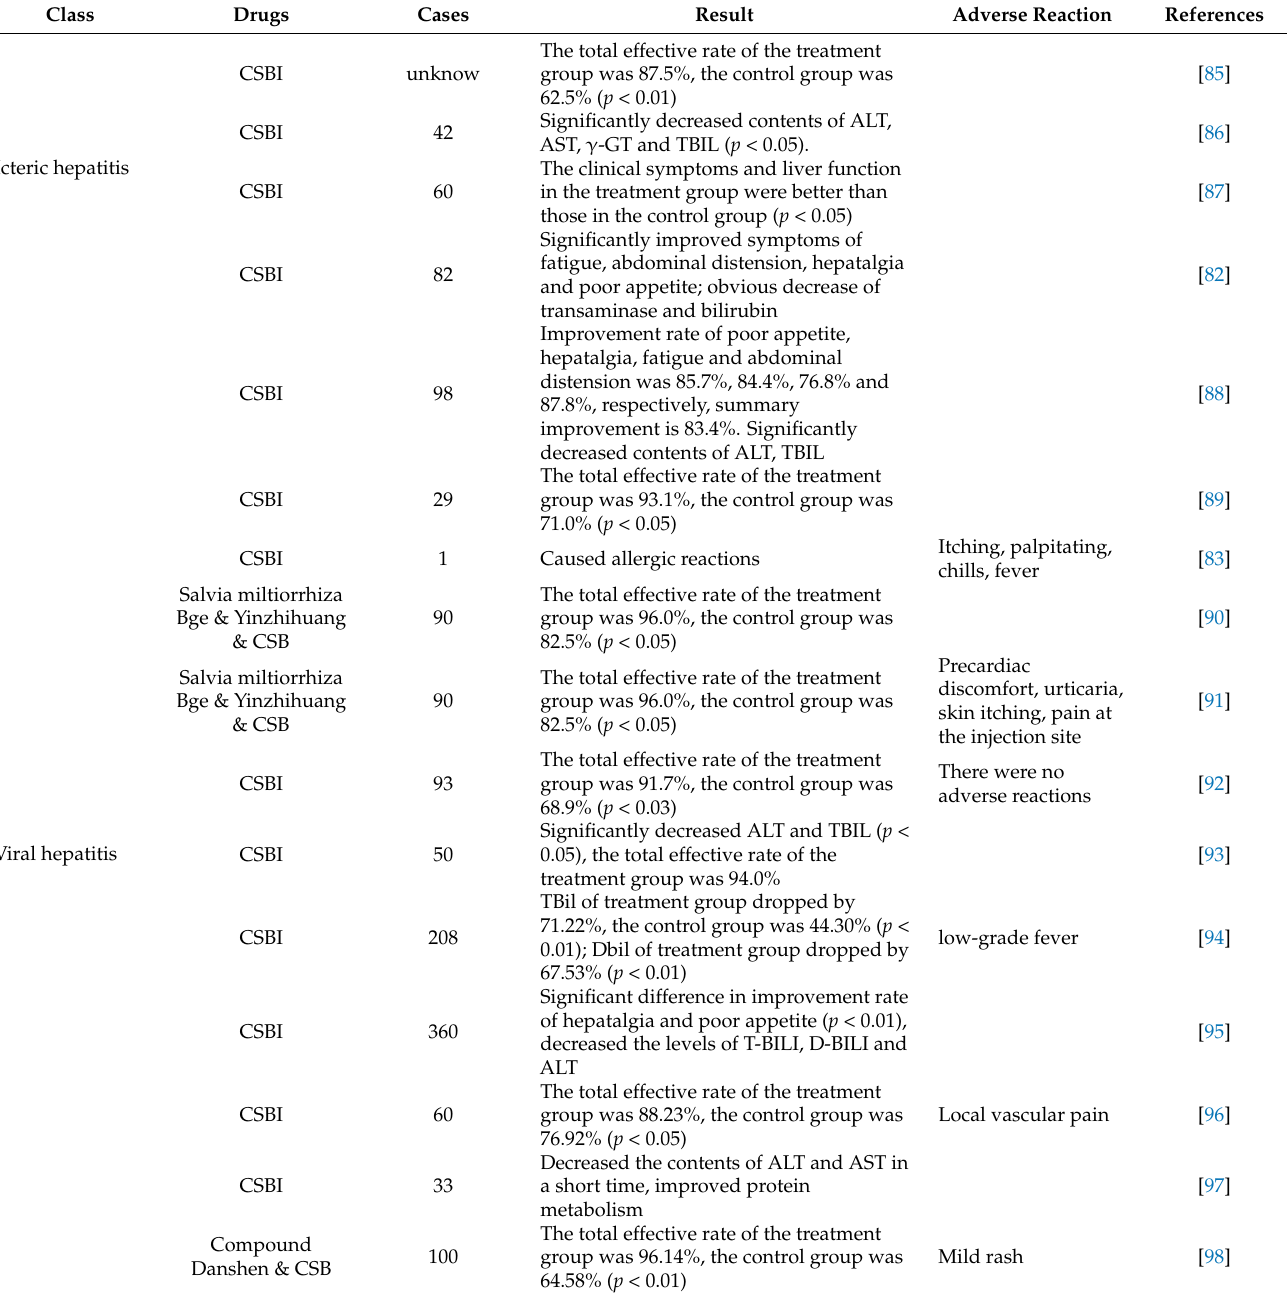
Table 3. The clinical application of Corydalis saxicola